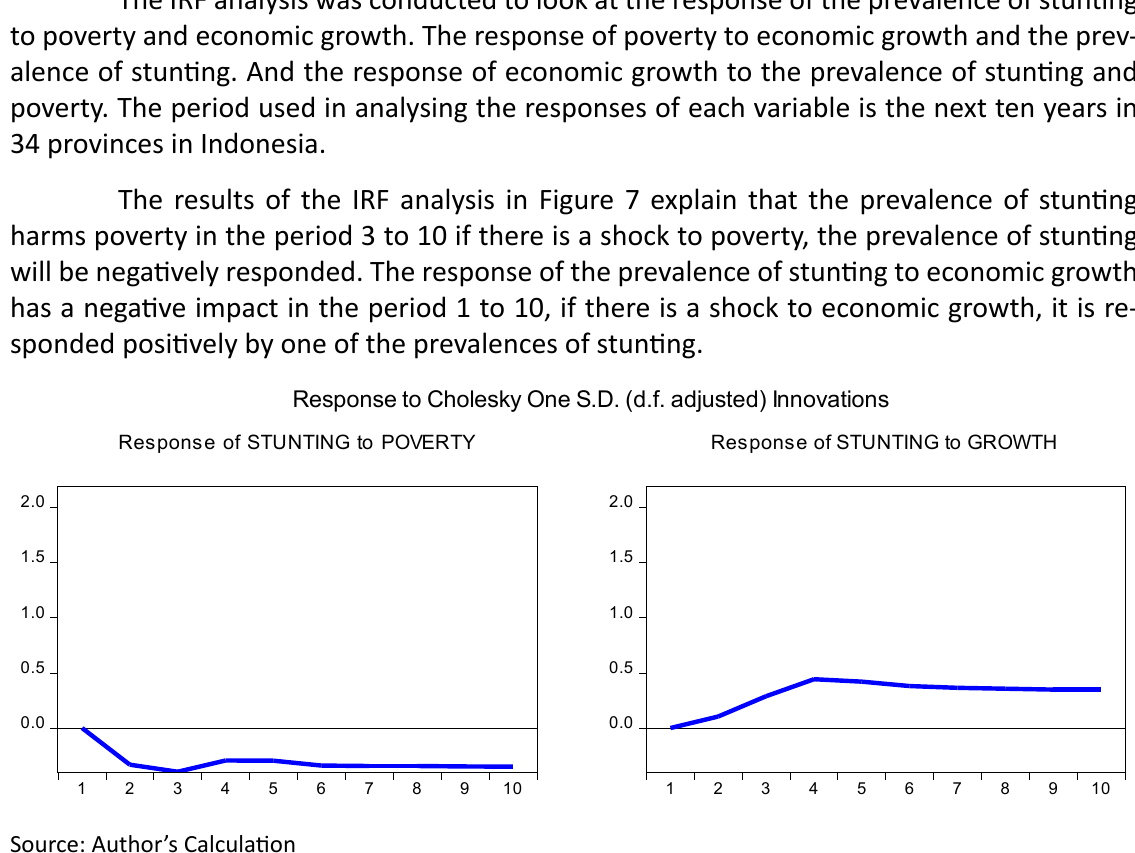
Figure 7: Impulse Response Function The Prevalence of Stunting Due to Shock Poverty and Economic